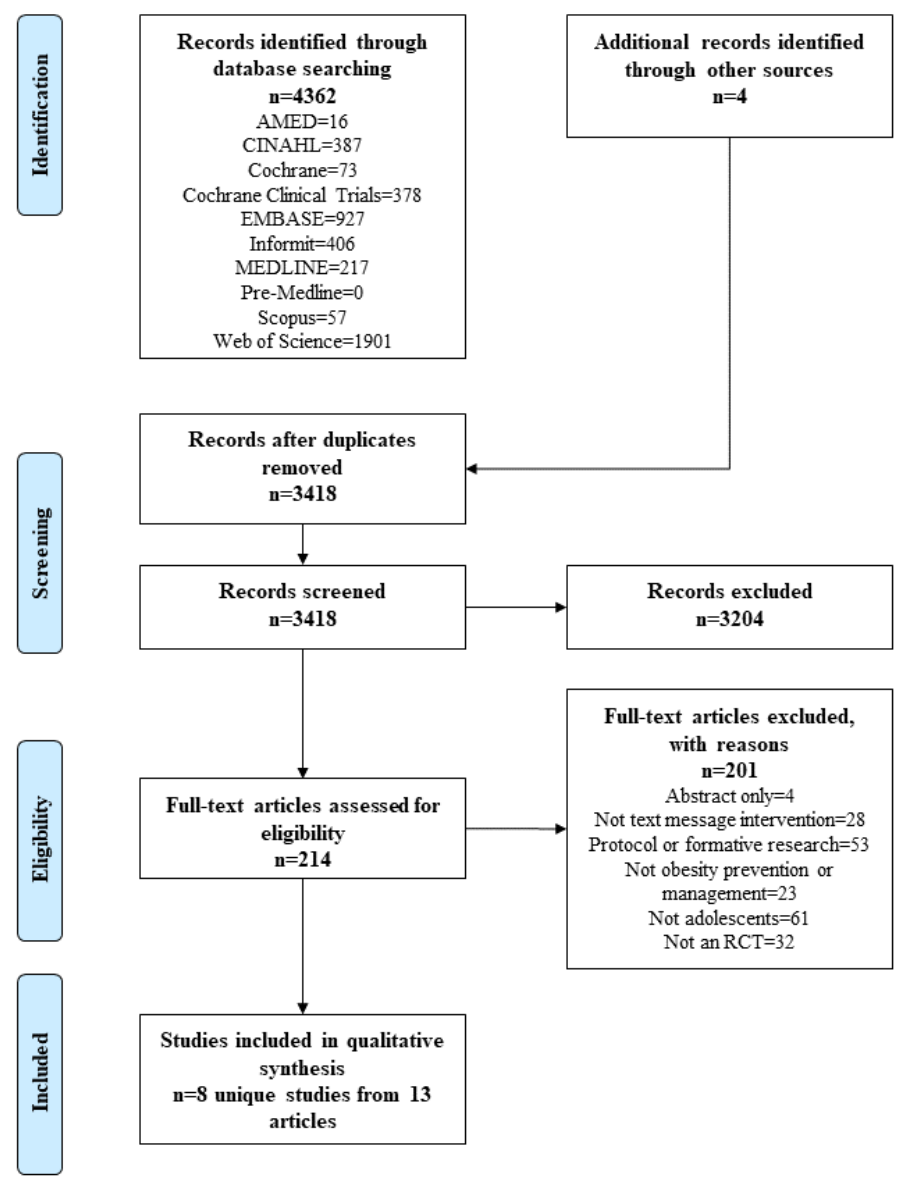
Figure 1. Preferred Reporting Items for Systematic Reviews and Meta-Analysis (PRISMA) flow diagram of included studies. RCT: